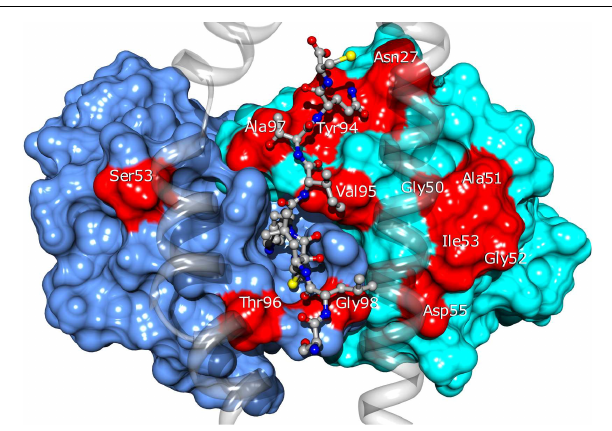
( Figure 11A ), translating into a calculated favorable ∆∆ G bind